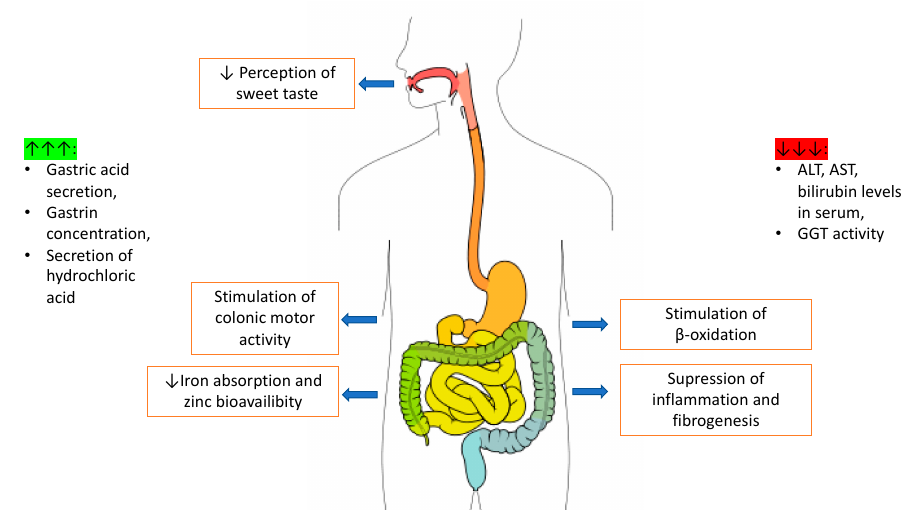
Figure 4. The scheme of the main effects of caffeine action on the digestive system. ALT—alanine aminotransferase, AST—aspartate aminotransferase, GGT— γ -glutamyltransferase. ↓↓↓ —decrease, ↑↑↑ —increase